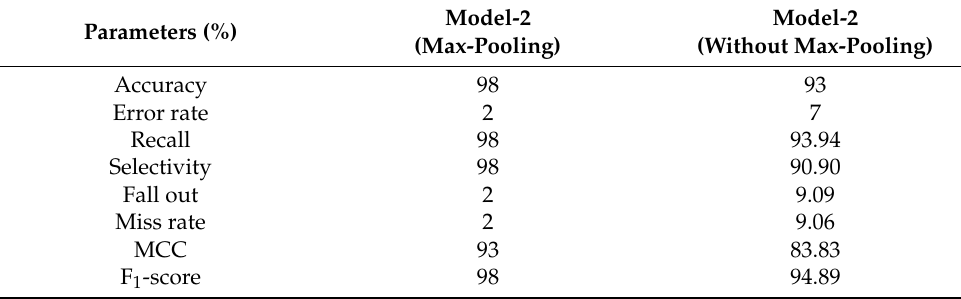
Table 3. Performance Evaluation of Proposed CNN Model-2.